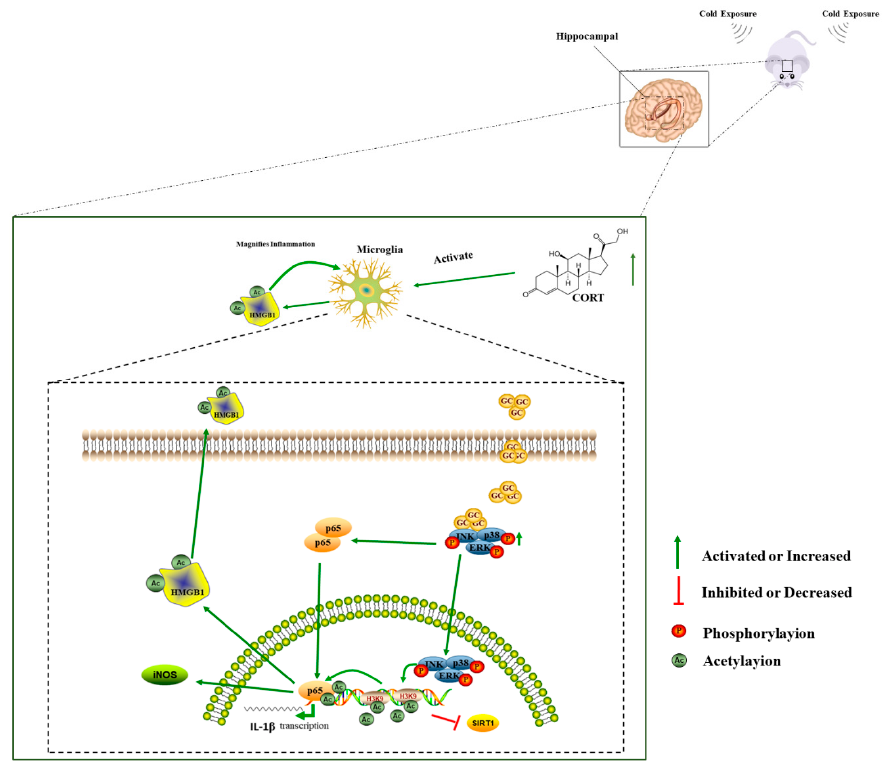
Figure 15. Proposed model for the mechanisms of microglia activation induced by cold stress in the hippocampus.